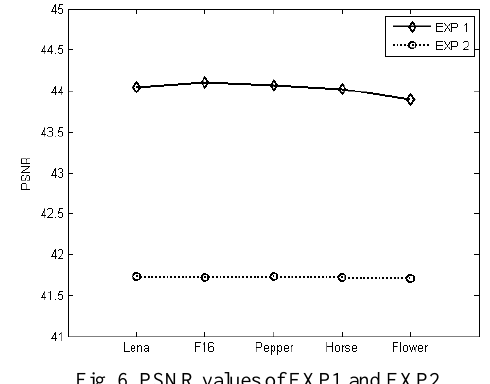
Fig. 6. PSNR values of EXP1 and